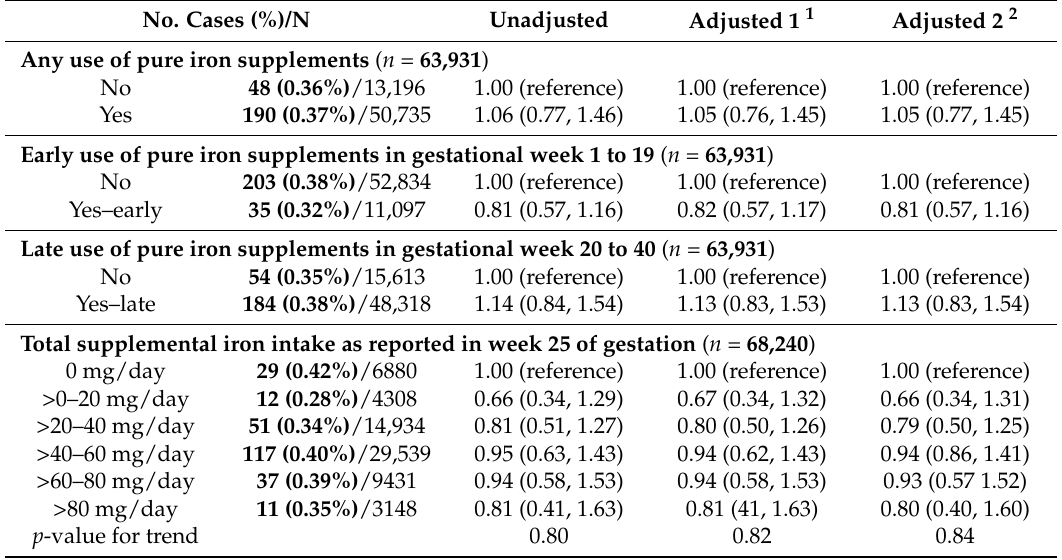
Table 2. Associations between maternal intake of pure iron supplements during pregnancy and total intake of iron from supplements in relation to offspring risk of type 1